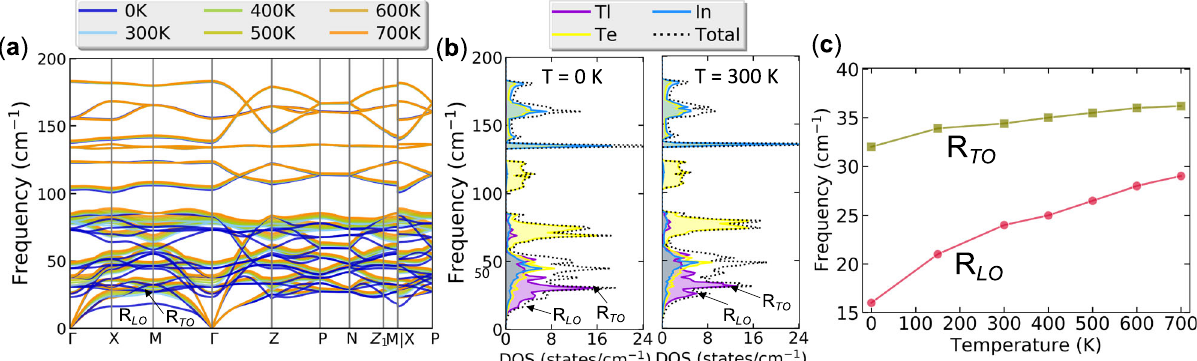
Fig. 2 Temperature-induced anharmonic phonon renormalization. a Anharmonically renormalized phonon dispersions of TlInTe 2 at fi nite temperatures (0 – 700 K). The longitudinal optical ( R LO ) and transverse optical ( R TO ) rattling phonon branches at T = 0 K are marked with arrows. b Atom-resolved phonon density of states of TlInTe 2 at 0 K and 300 K, where the peaks associated with the R LO and R TO phonons are indicated. c Variations of the R LO and R TO modes at the X-point in the Brillouin zone as a function of